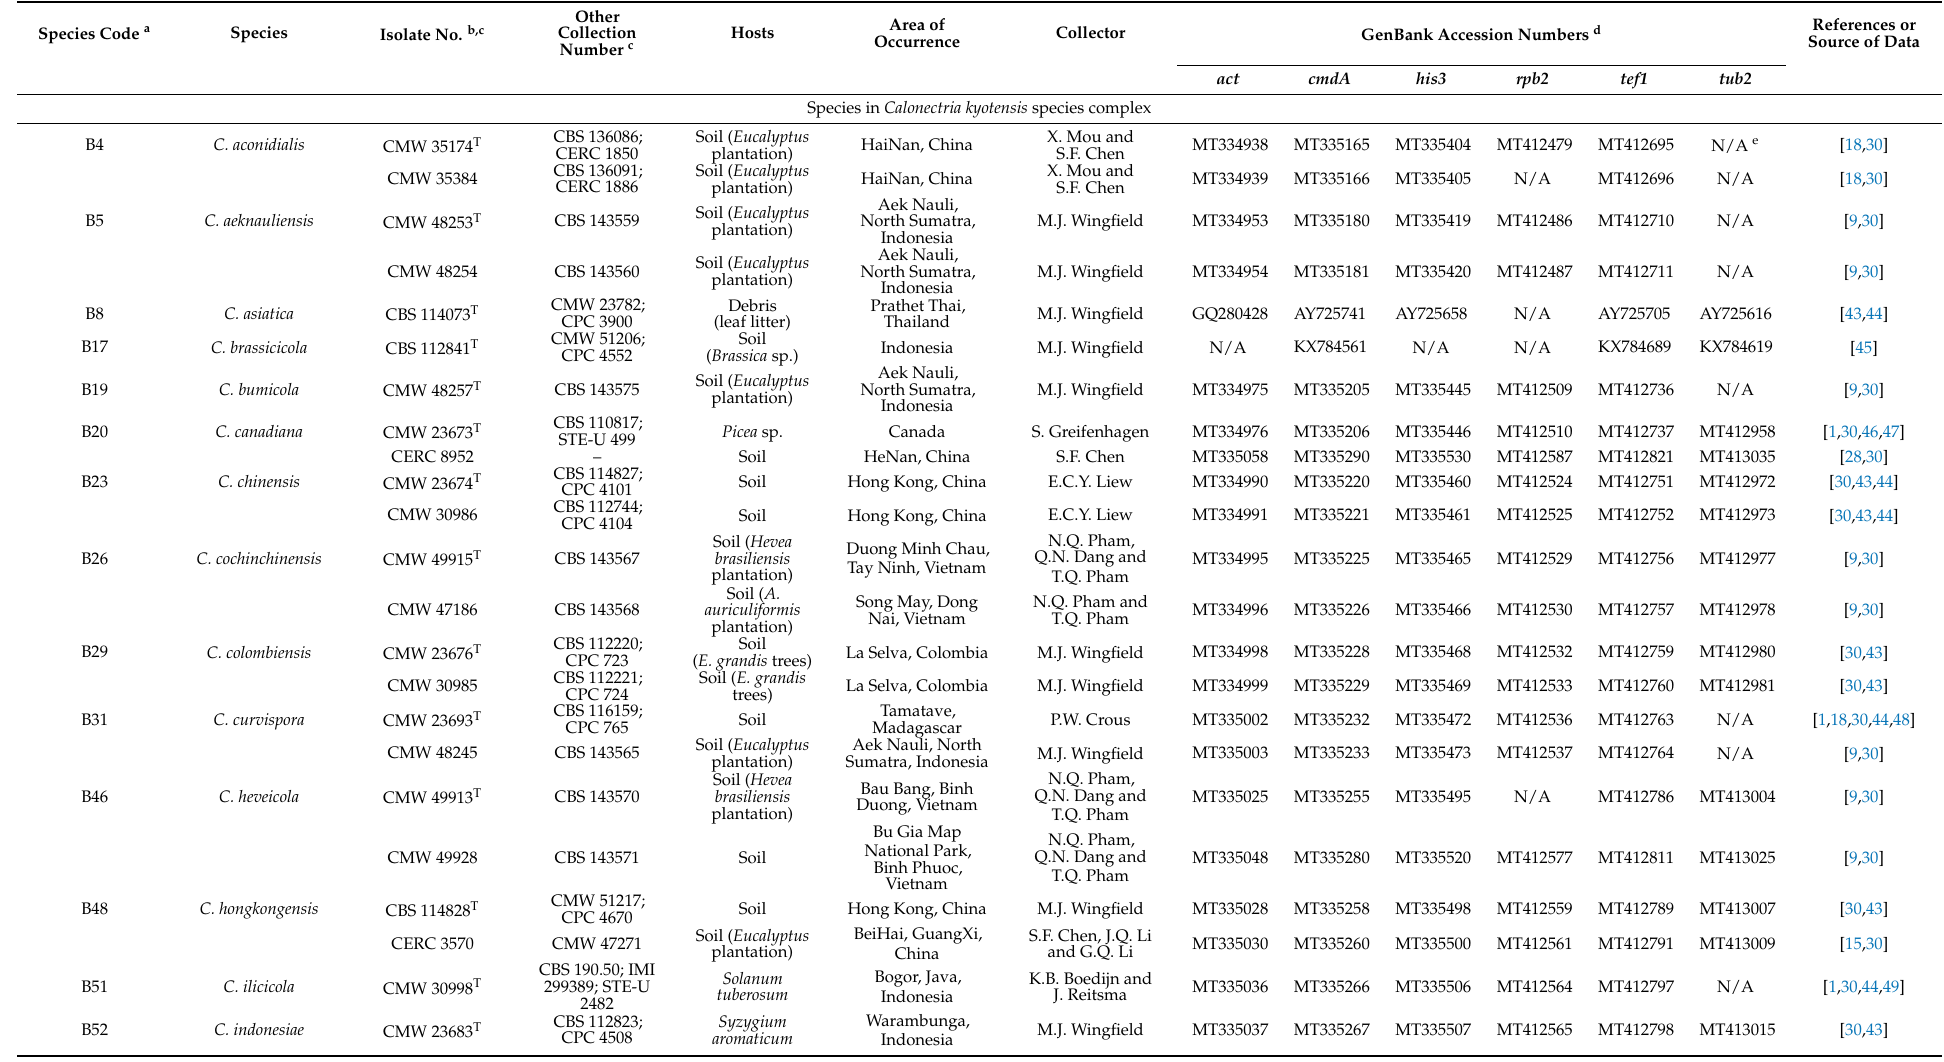
Table 4. Isolates from other studies used in phylogenetic analyses in this